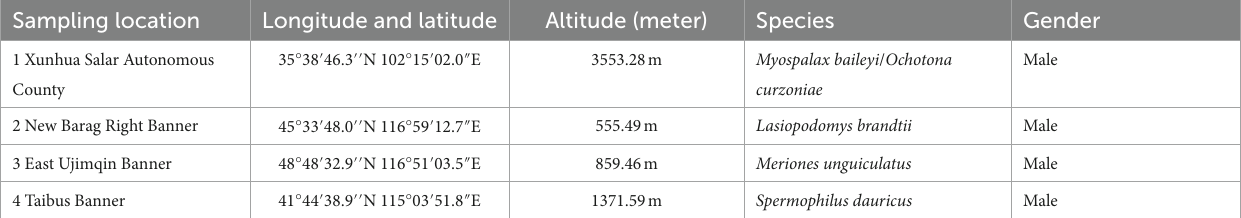
TABLE 1 Sampling location and sample data